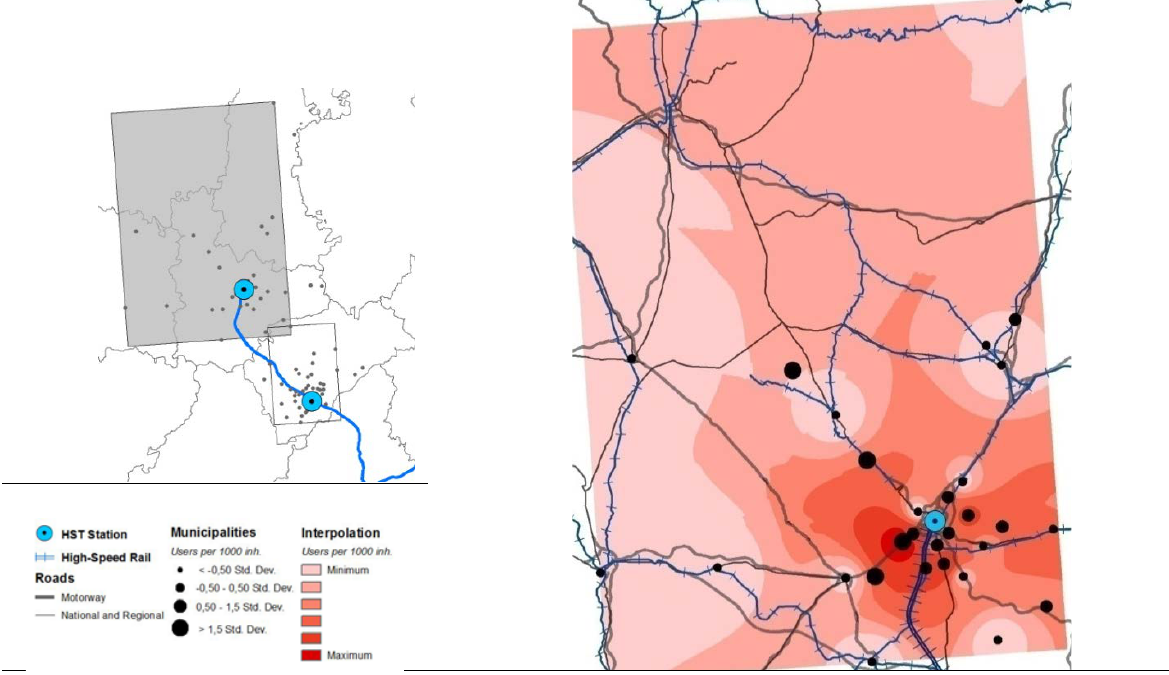
Figure 5. Zaragoza’s catchment